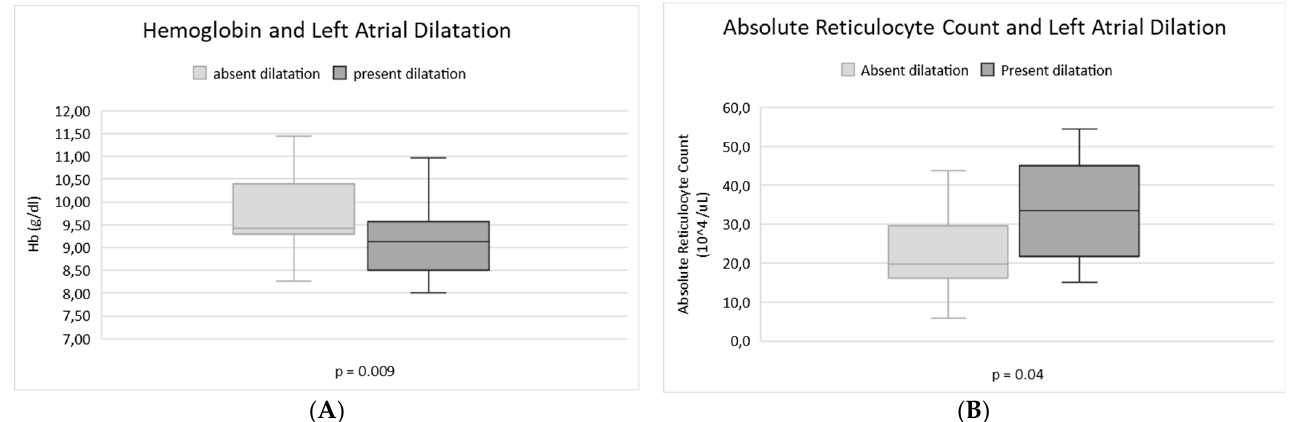
Figure 1. Correlation between LAD and markers of haemolytic anaemia. Box plot showing lower median Hb level ( A ), increased absolute reticulocyte count ( B ) in patients with left atrial dilatation compared to patients without this echocardiography alteration.